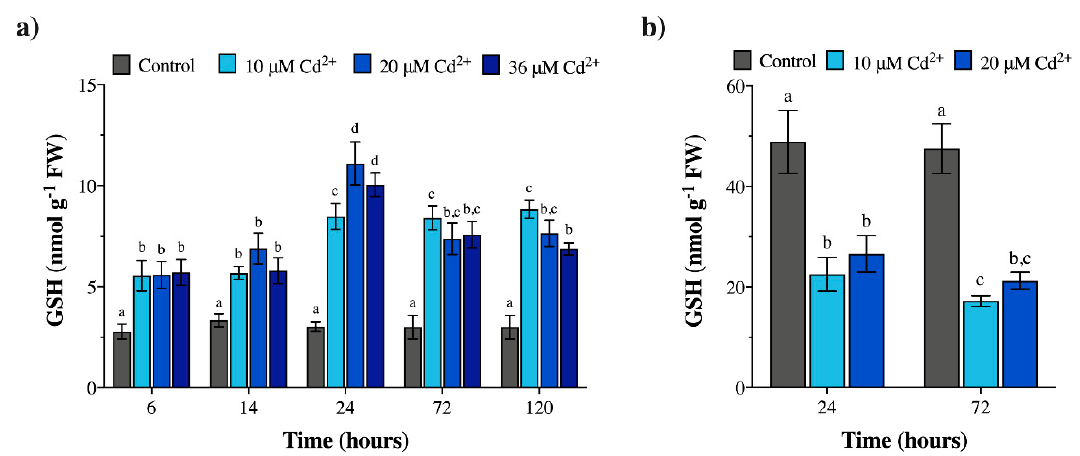
Figure 3. Glutathione (GSH) concentrations (nmol g − 1 FW) in ( a ) M. polymorpha exposed to 0 (control), 10, 20, and 36 µM Cd for 6, 14, 24, 72, and 120 h; ( b ) Geitlerinema sp. PCC 7407 exposed to 0 (control), 10, and 20 µM Cd for 24 and 72 h. Values are the mean ± SE; n = 5. Different letters indicate significant